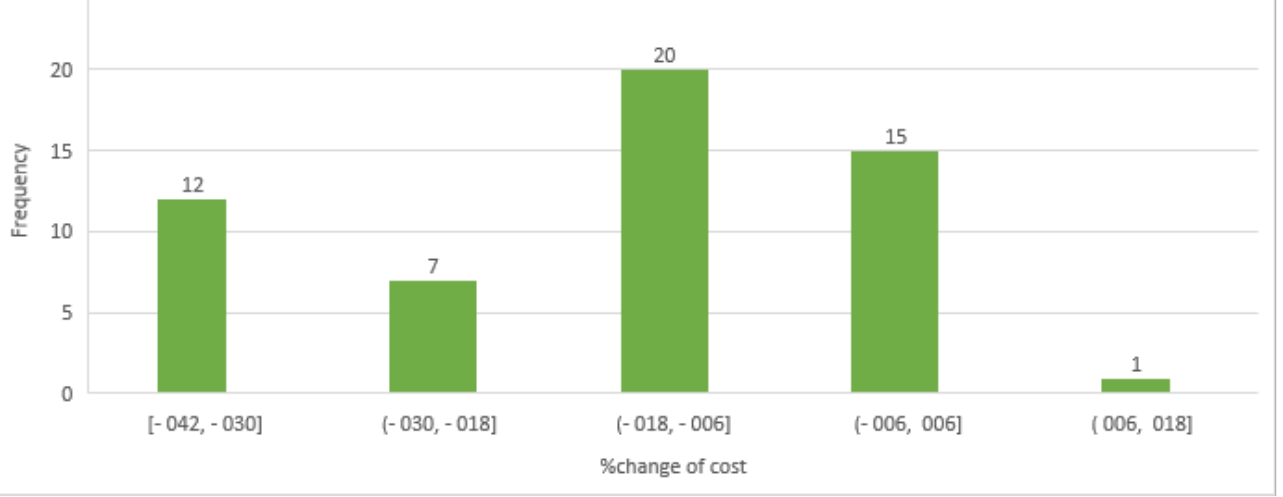
Figure 3. Histogram of the distribution of the analyzed parameters — cost reductions as percentages.